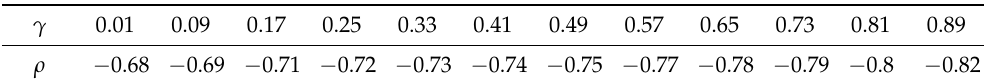
Table 6. Values of the rho of Spearman of the GCC copula for θ = ( − 1/ γ , − γ , − 1 ) and several values of γ , belonging to Configuration